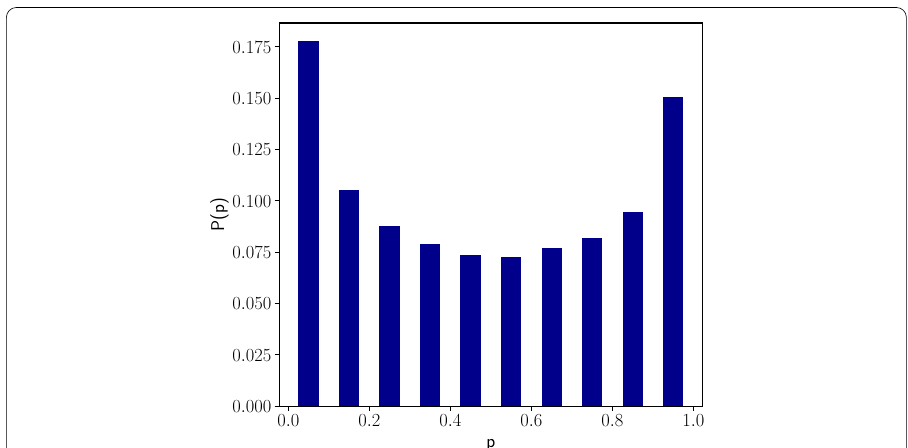
Fig. 9 Probability distribution of p probability of voting for Macri ( p = 0 corresponds to Fernández) = obtained by the Logistic Regression model